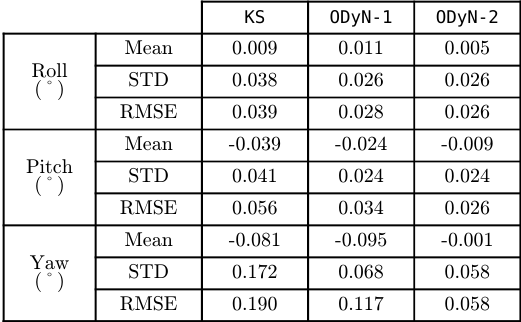
Figure 7. Residuals for the GNSS position observations.